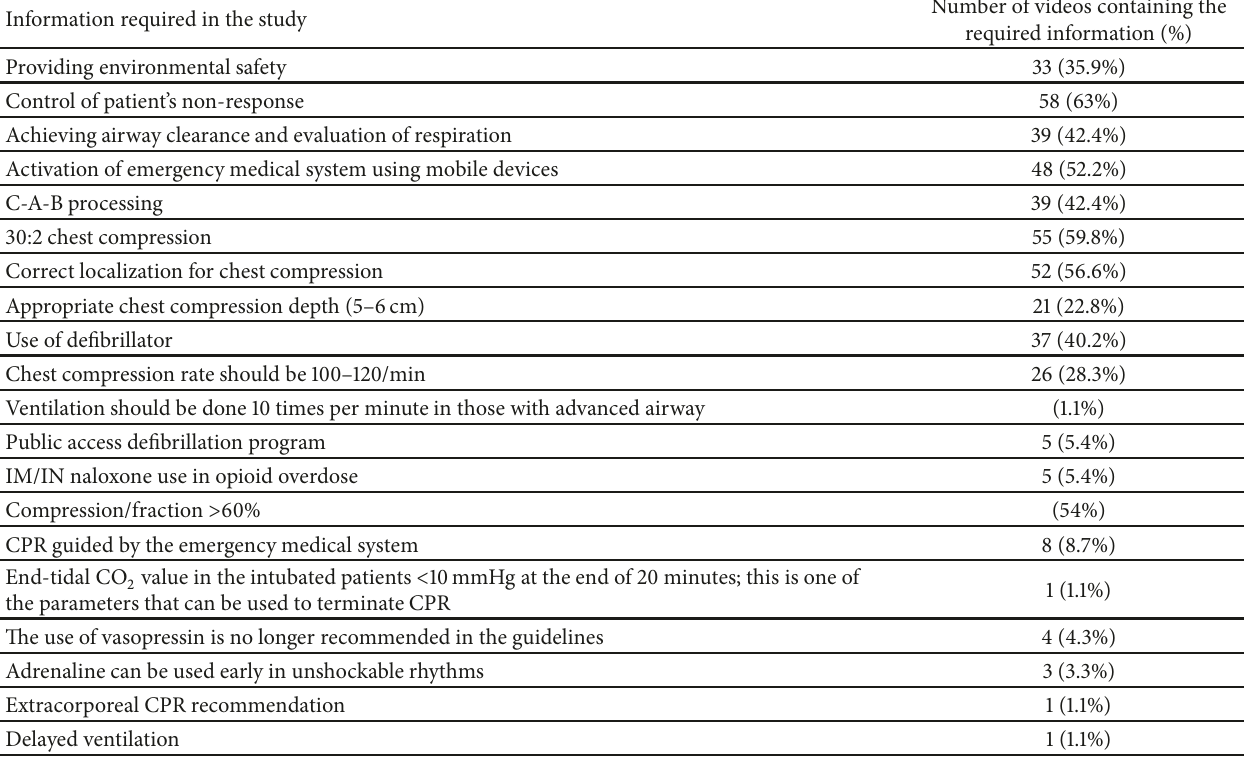
Table 4: Number of videos containing information for each criterion.